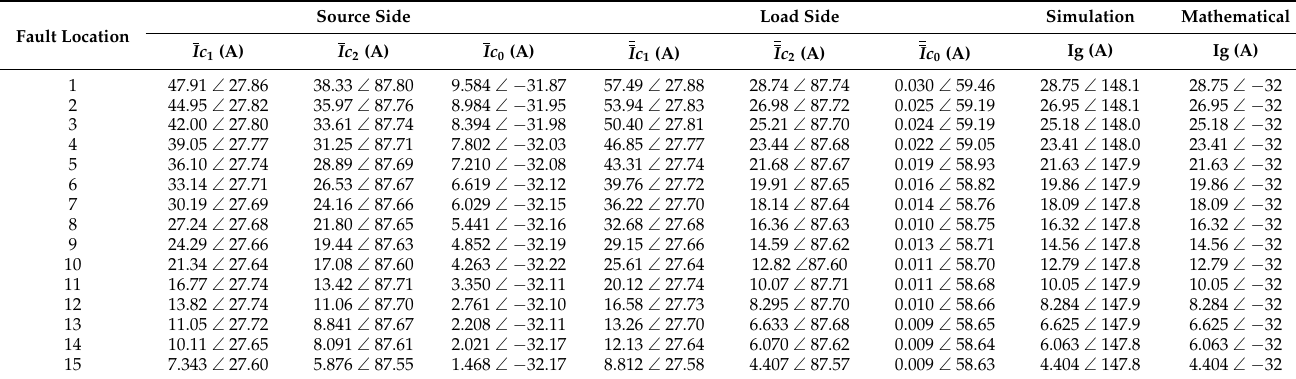
Table 4. Comparison between simulation and mathematical